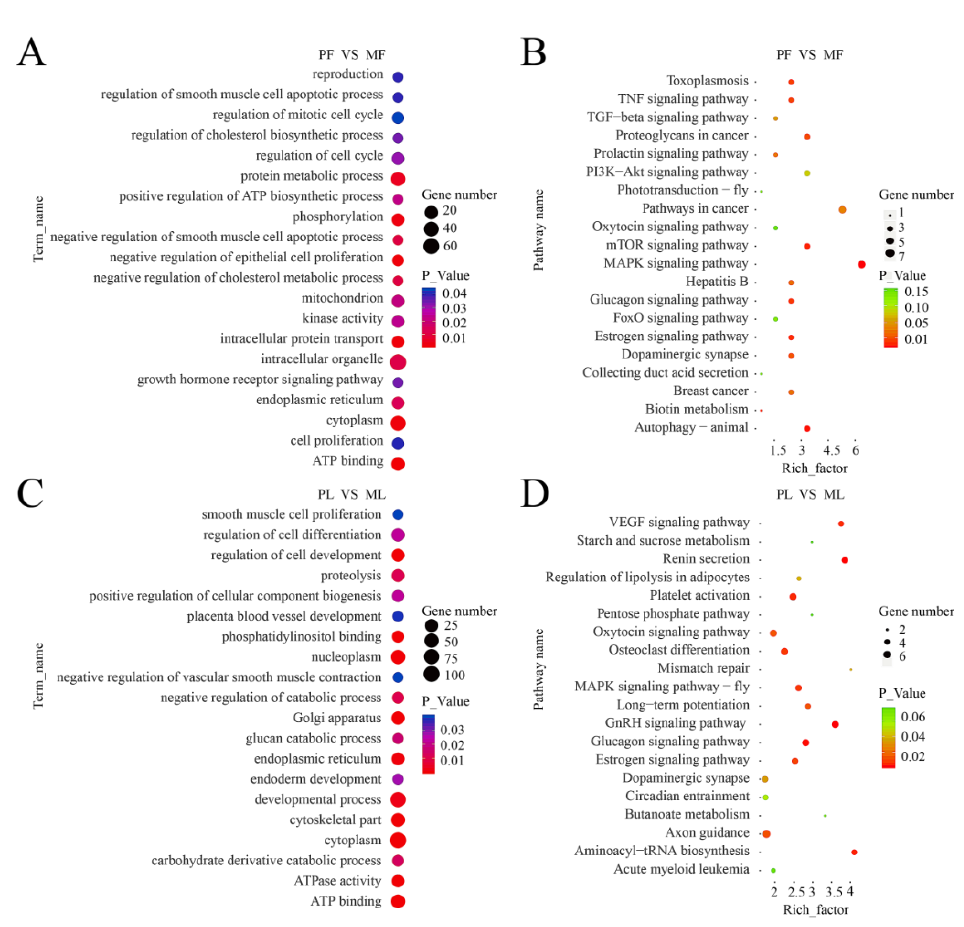
Figure 3. GO and KEGG analyses of differentially expressed circRNA host genes. ( A ) GO functional analysis of differentially expressed circRNA host genes in the follicular phase. ( B ) KEGG analysis of differentially expressed circRNA host genes in the follicular phase. ( C ) GO functional analysis of differentially expressed circRNA host genes in the luteal phase. ( D ) KEGG analysis of differentially expressed circRNA host genes in the luteal phase. The longitudinal and horizontal axes represent the enrichment pathways and rich factor (amount of differentially expressed genes enriched in the pathway / amount of all genes in the background gene set) of these pathways, respectively. The spot size represents the number of differentially expressed genes enriched in each pathway, and the color of the spot represents the p -value of each pathway.